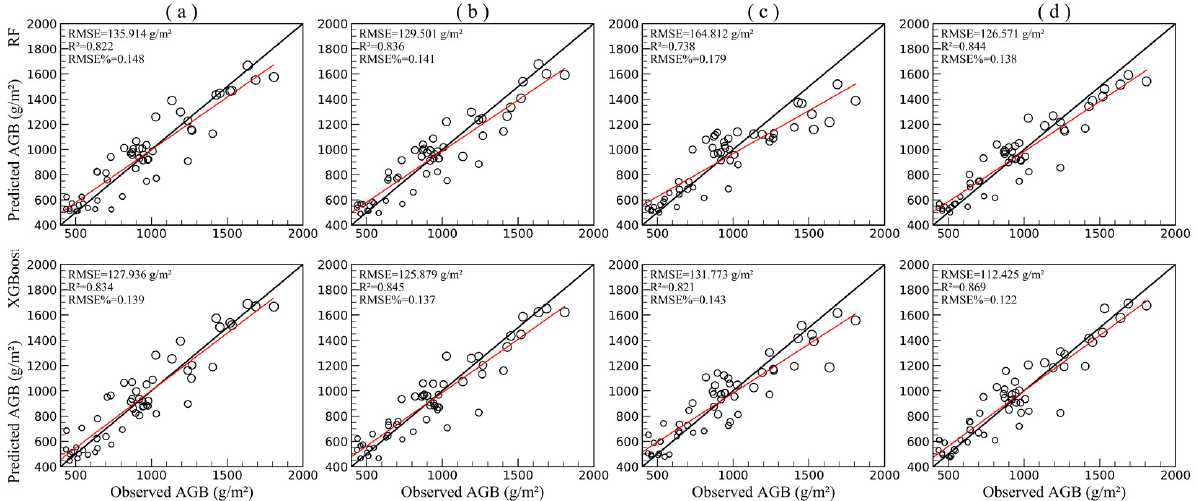
Figure 2. Relationship between observed and predicted biomass values of the training data set using RF and XGB regression models. ( a ) Bands and traditional VIs, ( b ) bands and red-edge VIs, ( c ) bands and textures, and ( d ) all variables combined.